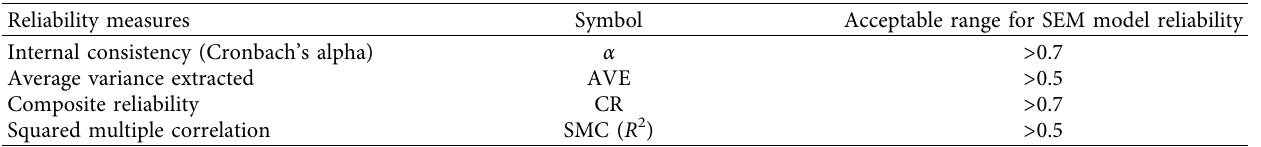
Table 8: Acceptable values for evaluation of model reliability.